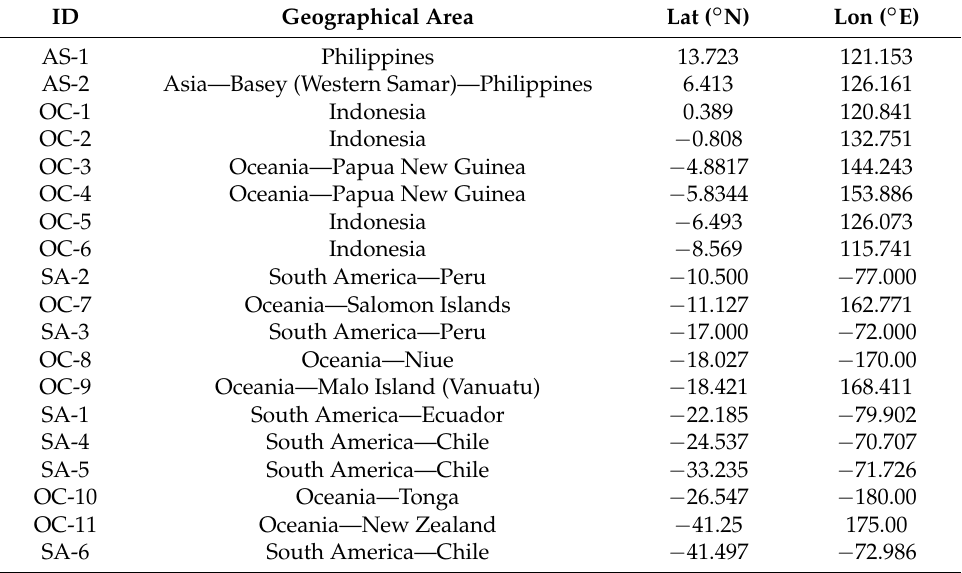
Table 3. Proposed ELF Observatories (500